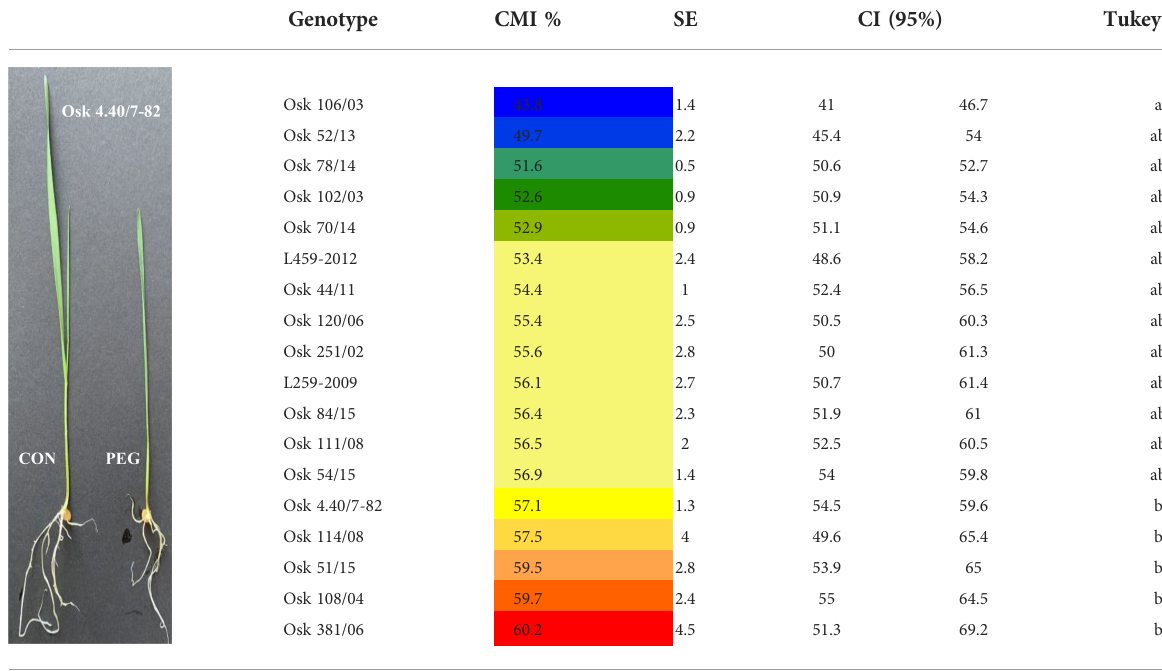
TABLE 1 The initial screening and ranking of 18 different winter wheat genotypes based on cell membrane stability of wheat seedlings expressed as cell membrane integrity (CMI %) obtained by PEG test.